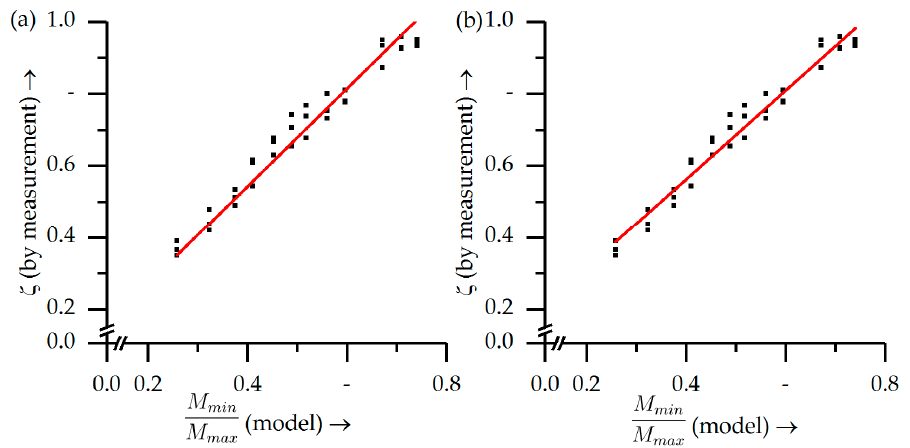
Figure 4. Experimental validation of the analytical estimation model for U > 1: ( a ) directly proportional relation; ( b ) linear fit. Table 2. Regression analysis of the experimental data.